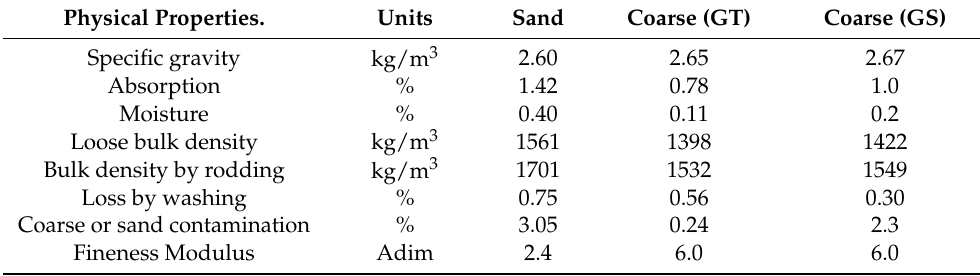
Table 3. Physical properties of